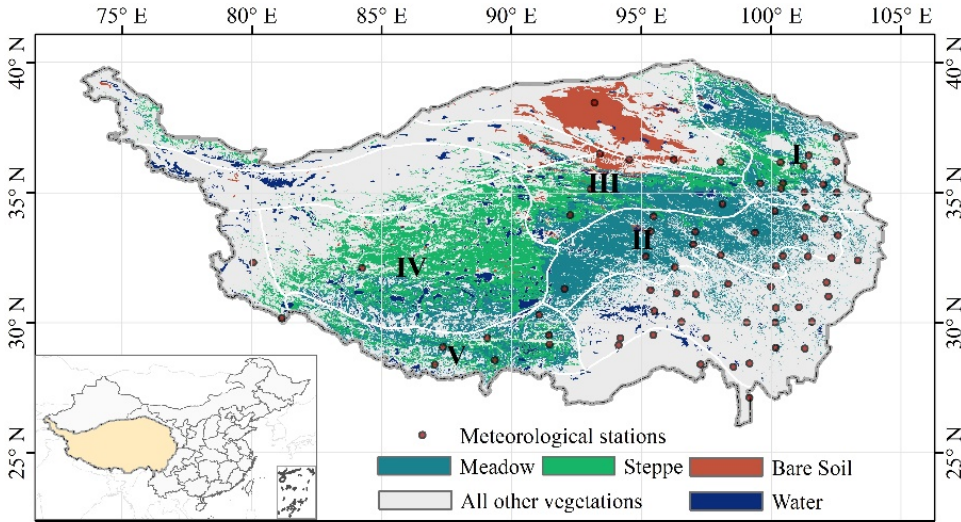
Figure 1. Location, ecoregions, and vegetation distribution for Tibetan Plateau. (I) Indicates Eastern Qinghai–Qilian montane steppe ecoregions; (II) indicates Golog–Nagqu high-cold shrub-meadow ecoregions; (III) indicates southern Qinghai high cold meadow steppe ecoregions; (IV) indicates Qiangtang high-cold steppe ecoregions; and (V) indicates Southern Xizang montane shrub-steppe ecoregions [31]. Pixels with annual maximum normalized difference vegetation index (NDVI) greater than 0.15 and mean NDVI of July to August larger than 1.35 × NDVI during November to February are shown.